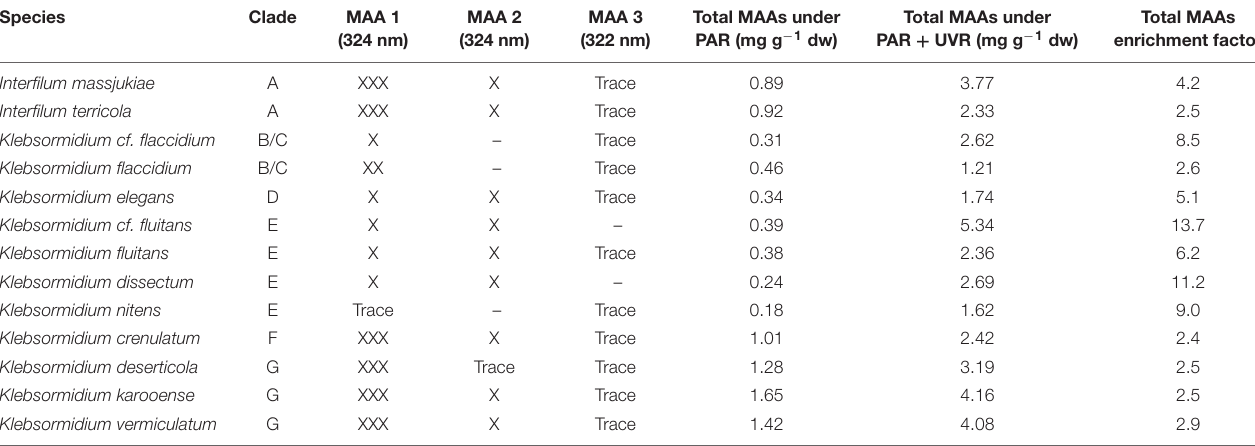
TABLE 2 | Species assignment, genetic lineage (clade) assignment of Interfilum and Klebsormidium (according to Rindi et al., 2011; Mikhailyuk et al., 2015), occurrence of MAAs (mycosporine-like amino acids) based on liquid chromatography and total MAA concentration (mg g − 1 dry weight) under PAR and PAR + UVR conditions. Species Clade